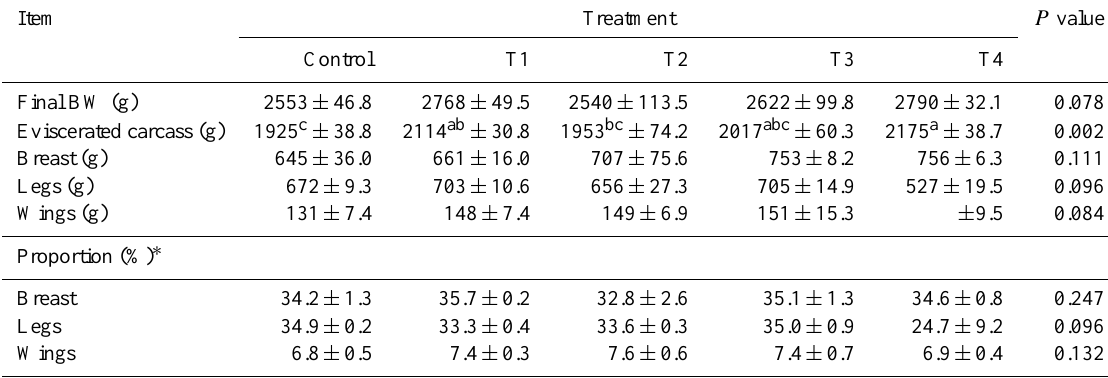
Table 3. Means ( ± SEM) of body weight, eviscerated carcass as well as the proportion of the broiler’s weight that these components make